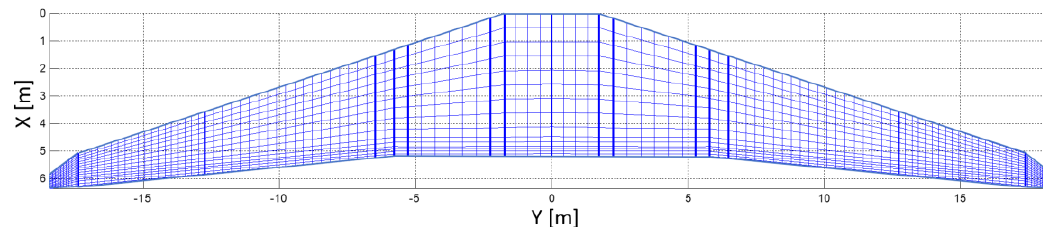
Figure 6. Aerodynamic mesh adopted for the reference wing (plan view).